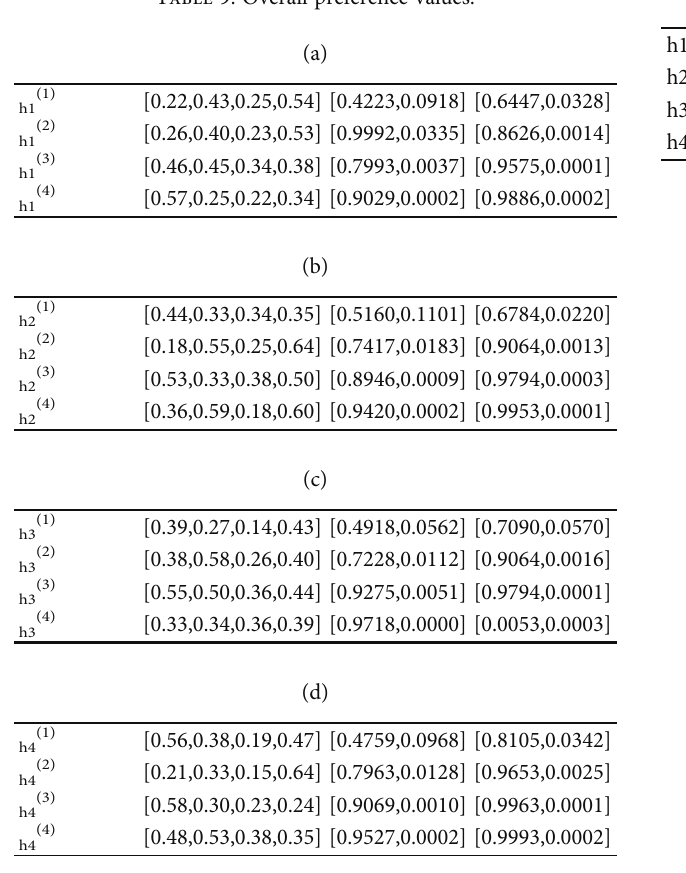
Table 9: Overall preference values.